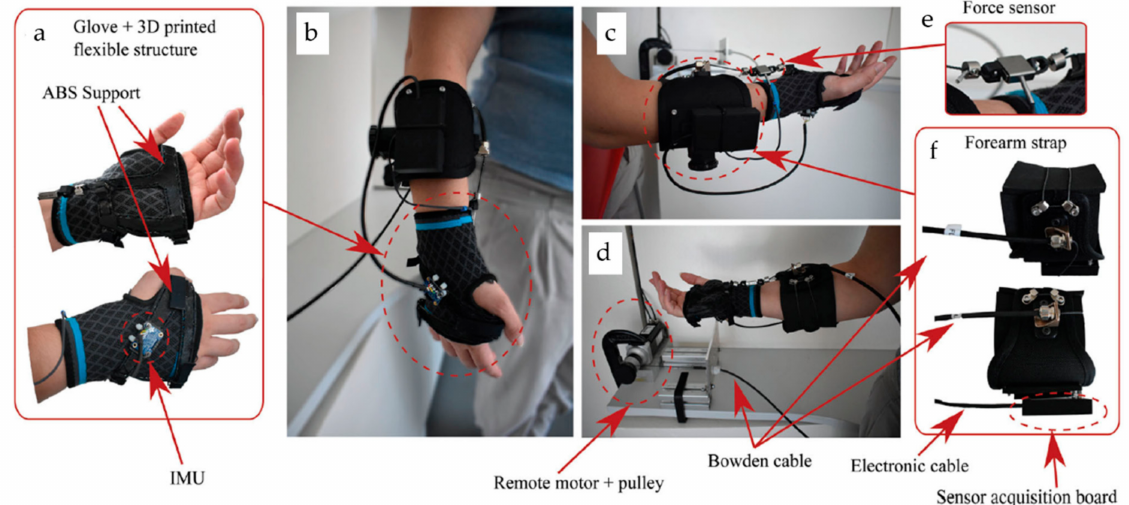
Figure 5. Cable-based soft exoskeleton for the wrist. ( a ) The glove together with the 3D printed flexible structure. ( b – d ) Bowden cables are driven by a remote motor and pulley. ( e ) A load cell was used to measure the force. ( f ) A strap wrapped around the forearm was employed to hold the Bowden cables and the sensor acquisition board [63] (Open